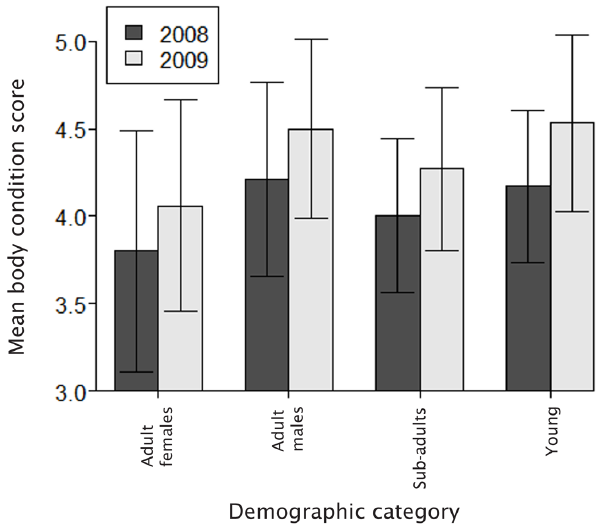
Figure 5. Mean body condition scores of buffalo during the 2008 and 2009 late flood seasons. Error bars represent one standard deviation.